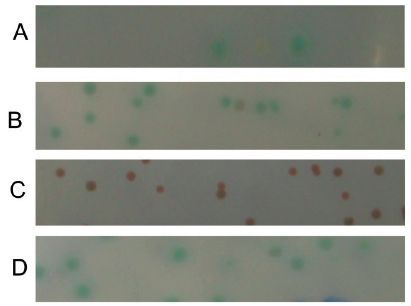
Figure 1. Yeast two-hybrid screening of the human fetal brain cDNA library using the Sec to Cys mutant of SelP (SelP') gene as a bait. ( A ) Plasmids carrying the fetal brain cDNA library were co-transformed into the NpGBKT7- SelP' -containing yeast and screened by the selection plate for blue colonies; Y2H Gold yeast cells in ( B )–( D ) were co-transformed with plasmids NpGBKT7- SelP' and pACT2- Tub to verify the interaction between SelP' and tubulin ( B ); or with plasmids pGBKT7-Lam and pADT7-T as the negative control ( C ); or with plasmids pGBKT7-p53 and pADT7-T as the positive control ( D ), followed by selection on SD/-Trp/-Leu/-His/-Ade/X- α -gal/Aba plates.